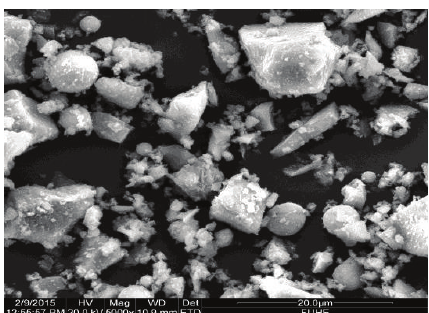
Figure 3: The SEM image of